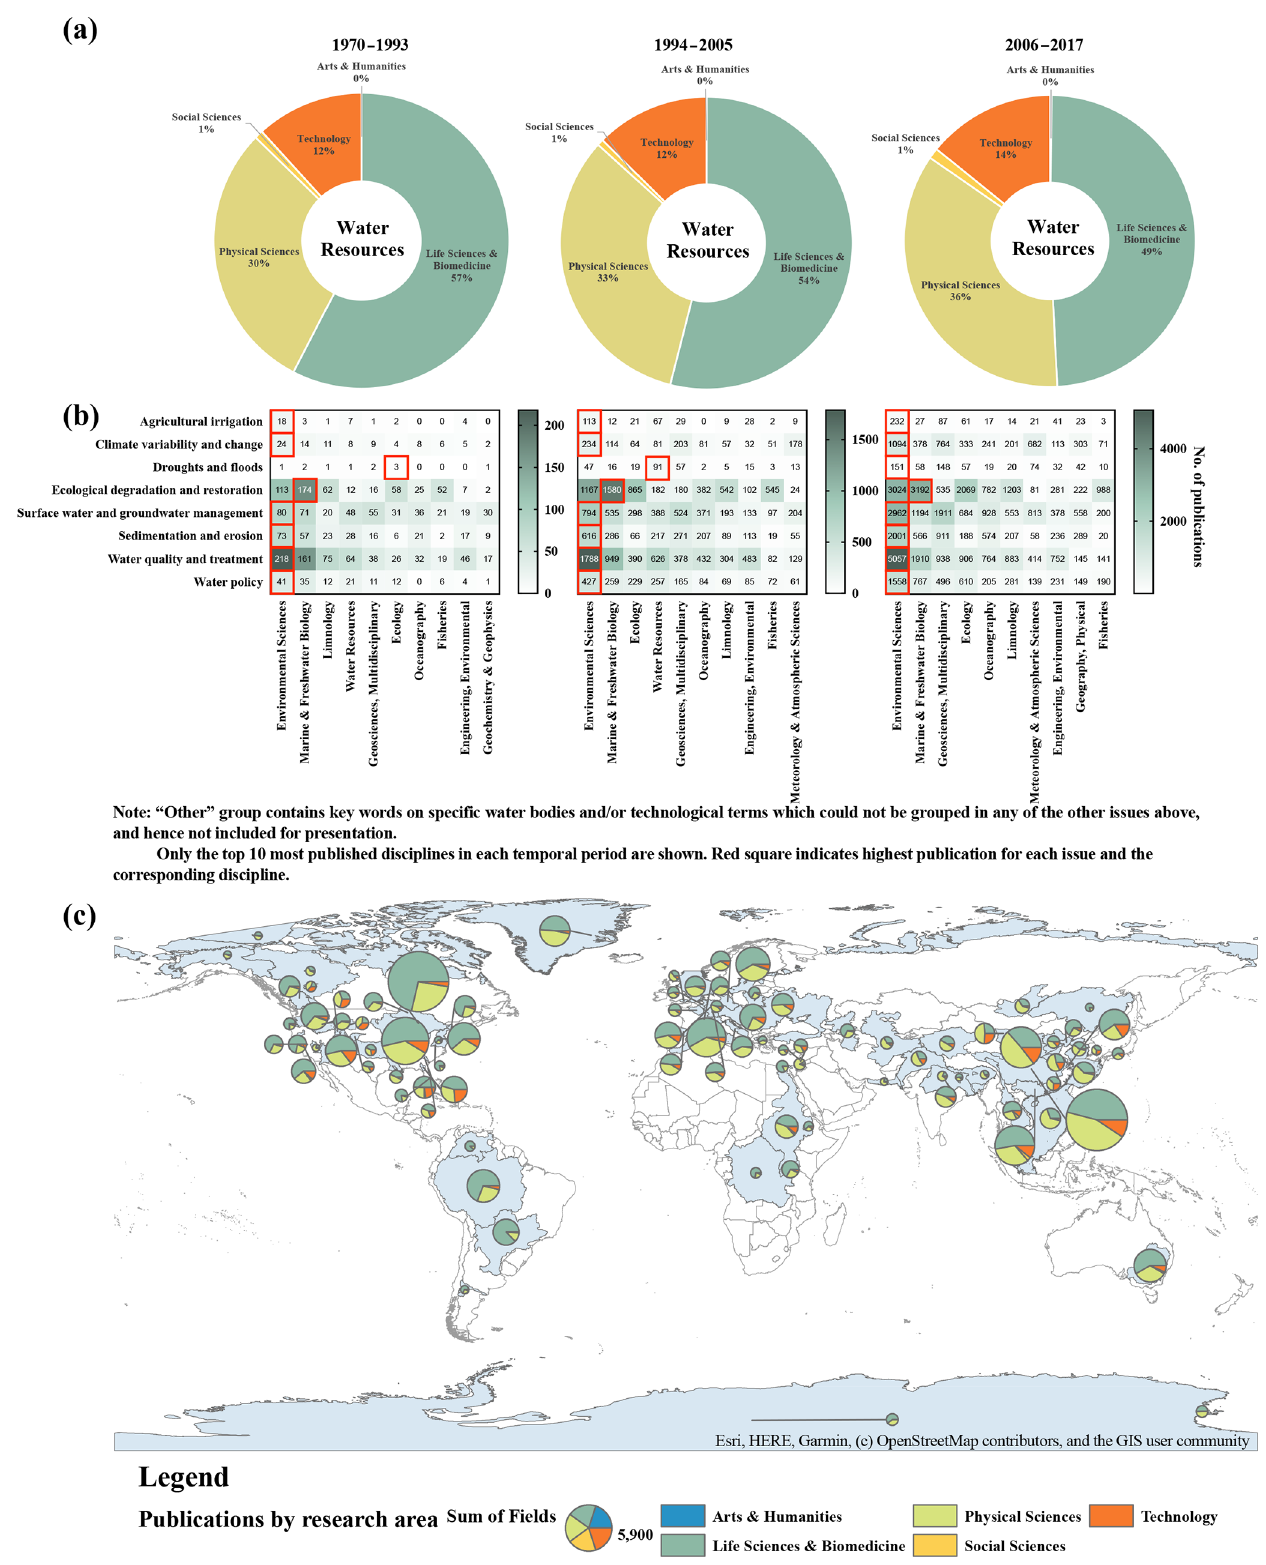
Figure 6. (a) The evolution of cross-disciplinary collaborations with the water resources discipline. (b) The evolution of links between management issues and the collaborations of the water resources discipline during 1970–1993, 1994–2005, and 2006–2017. (c) The spatial distributions of disciplines by research area in all